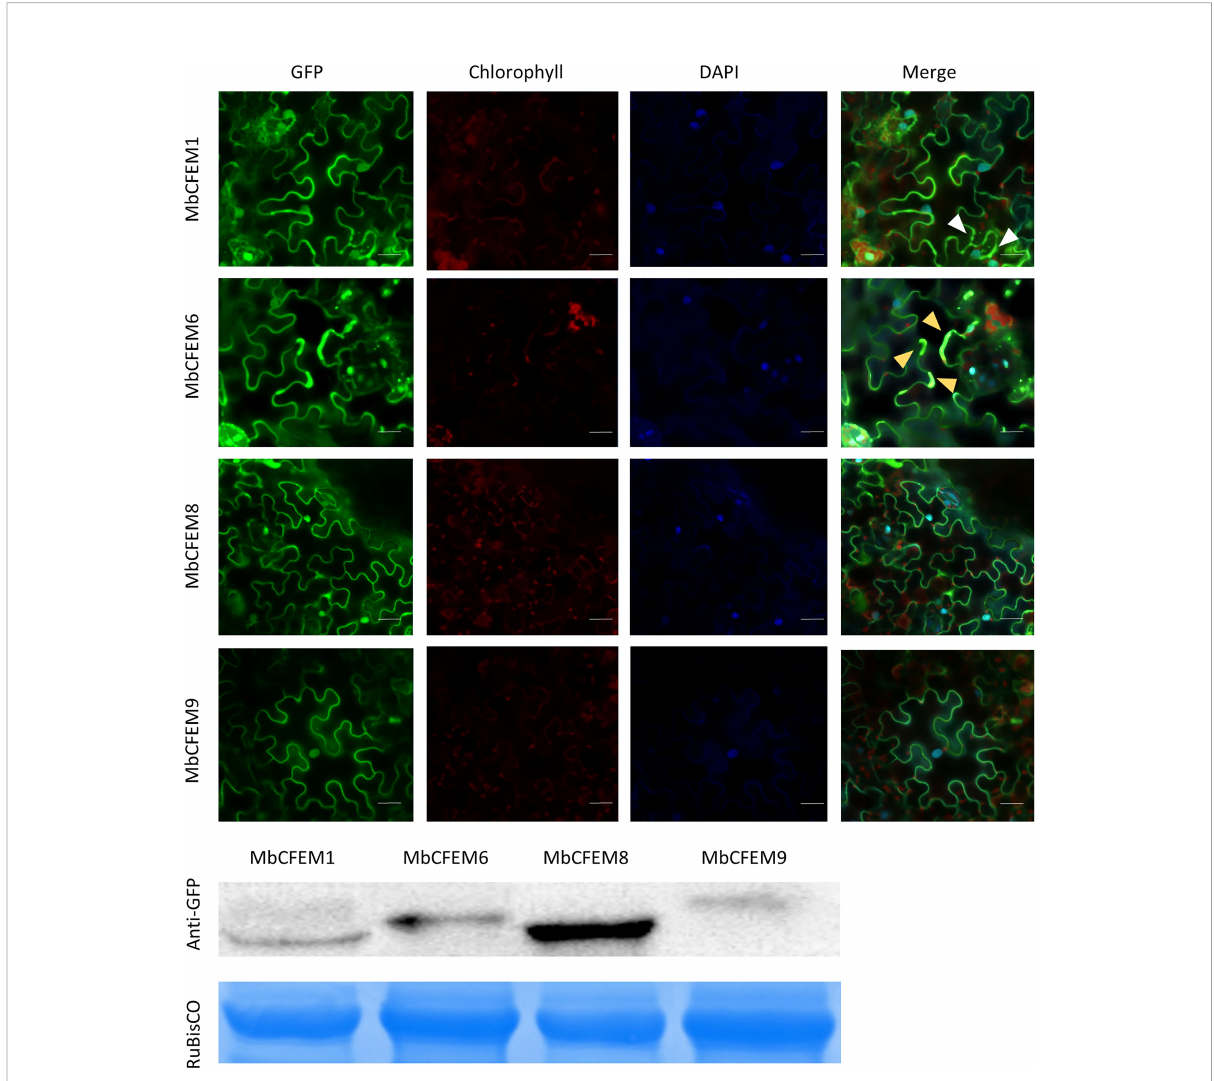
FIGURE 7 Subcellular localization of four candidate MbCFEM effectors in N. benthamiana. N-terminal GFP-tagged MbCFEM effectors were transiently expressed in N. benthamiana . 4 ’ ,6-diamidino-2-phenylindole (DAPI) was used as the marker of the nucleus. 10 leaves of N. benthamiana were used for each candidate MbCFEM effectors and the experiment was repeated three times. The subcellular localization was detected by a confocal laser-scanning microscope and the representative images were present. The DAPI signal, the chlorophyll signal and the GFP signal were captured with an excitation wavelength of 350 nm, 470 nm and 488 nm, respectively, and an emission of 461 nm, 680 nm and 510 nm, respectively. White arrowheads indicate the speckle-like cytosolic bodies (MbCFEM1). Yellow arrowheads indicate the chloroplast (MbCFEM6). Images displayed are overlays of the GFP signal, the chlorophyll signal, the DAPI signal, and the merged fi eld. Scale Bars = 100 m